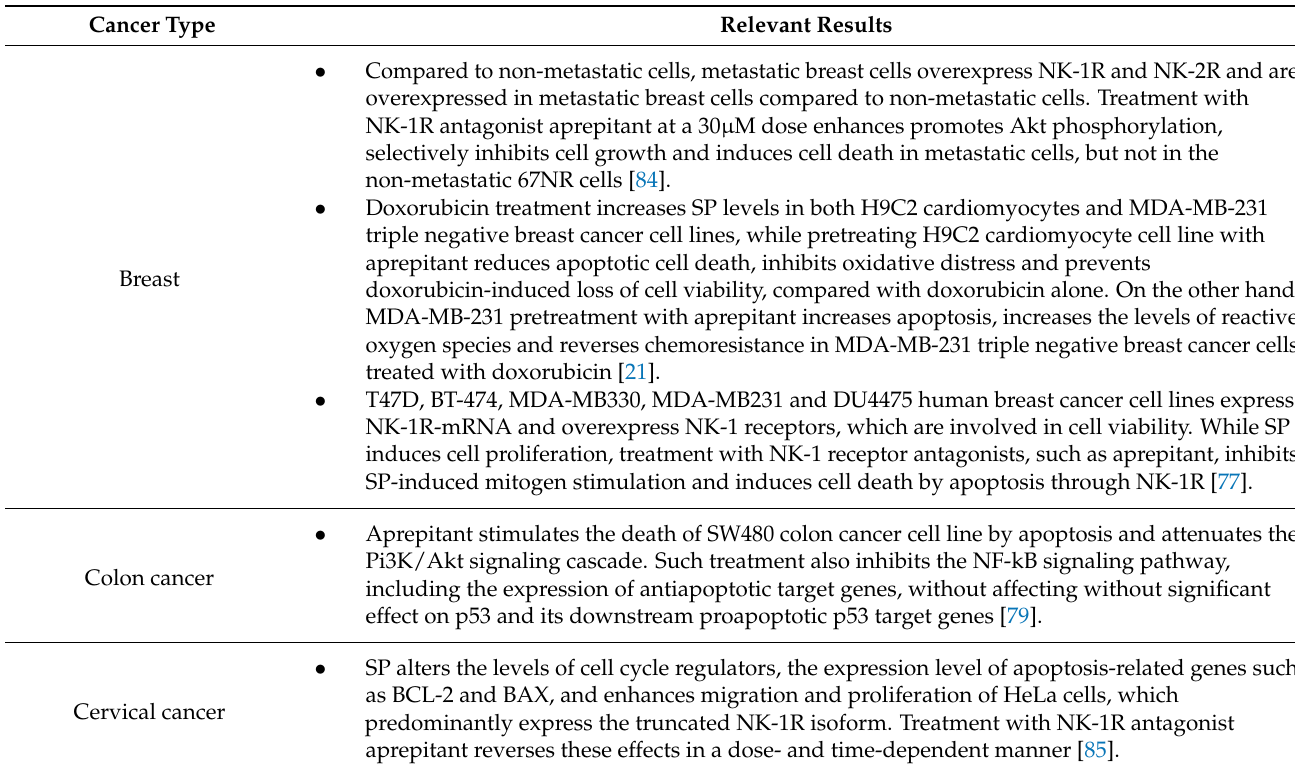
Table 2. Relevant results of preclinical